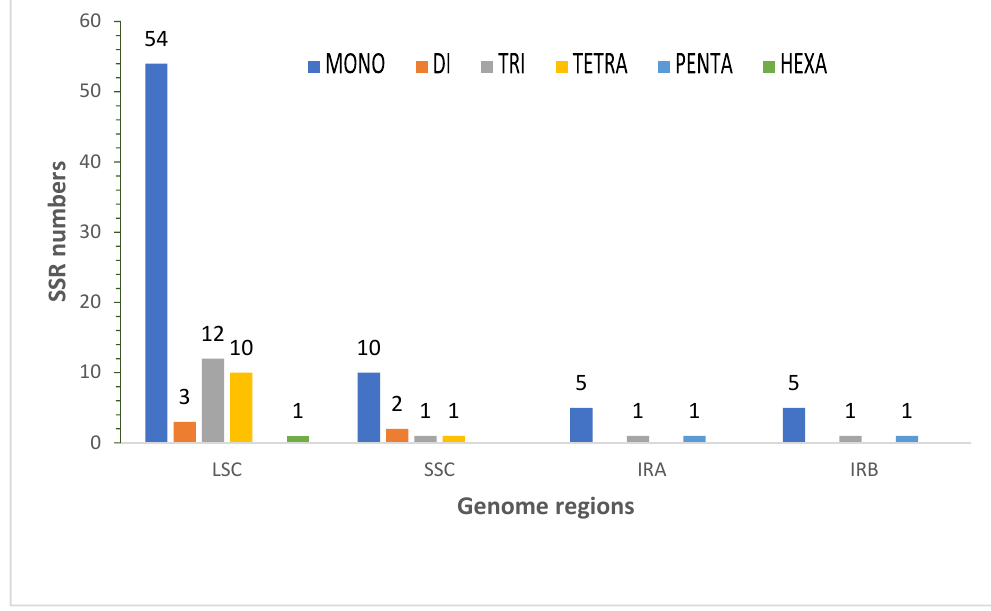
Figure 5. Analysis of SSRs in Fortunella venosa chloroplast genomes (frequency of identified SSRs in LSC, SSC, and IR regions). The Mono-, Di-, Tri-, Tetra-, Penta-, and Hexa- represents the nucleotide motifs of the SSRs present in the F. venosa genome.